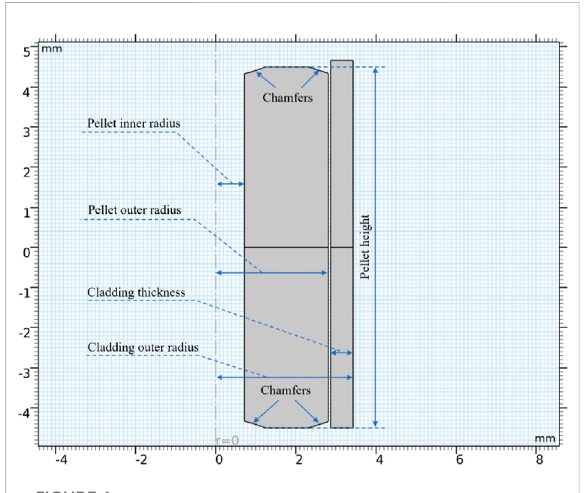
FIGURE 1 SchematicdiagramoftheannularMOXfuelusedinthiswork.